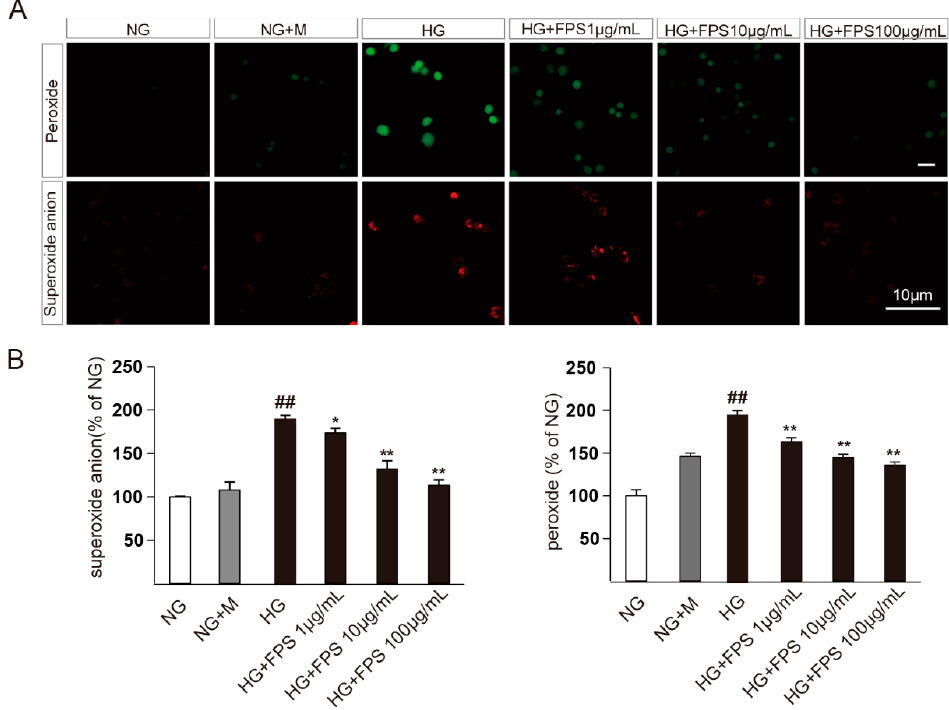
Figure 6. The effects of FPS on antioxidant in injured RSC96 Cells: ( A ) RSC96 cells were stained with DCFH 2 DA and DHE; and ( B ) the quantized data of peroxide and superoxide anion levels were expressed by mean ± S.D. ( n = 3). ## or ** p < 0.01; * p < 0.05; “##”, HG vs. NG; “*” or “**”, HG vs. HG + FPS. The ordinate is a percentage relative to NG group.